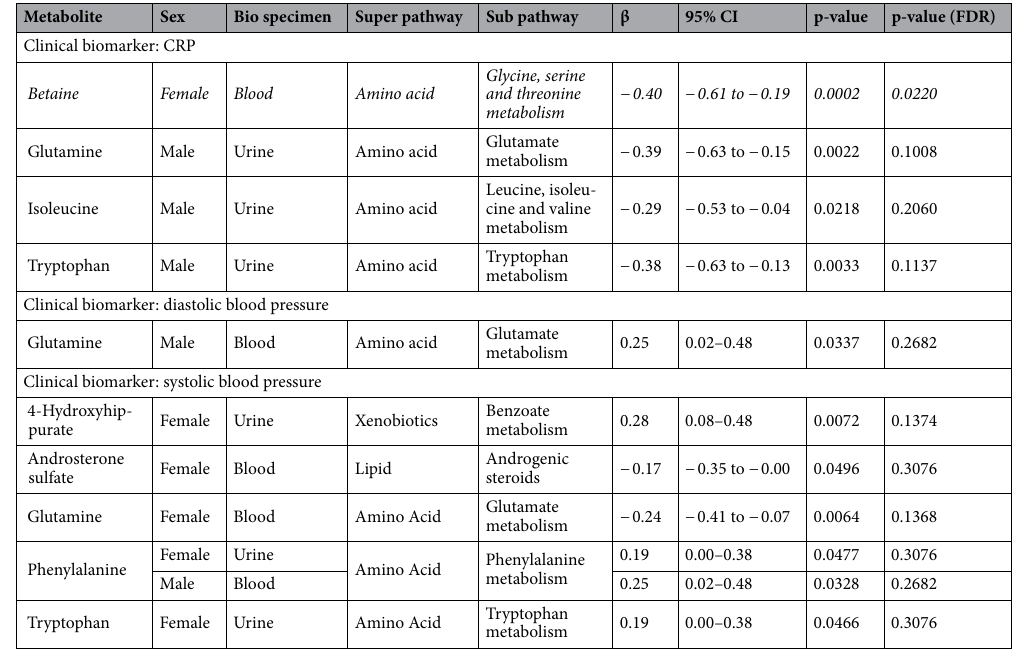
Table 3. Replicated risk-markers-metabolites association for CRP, diastolic blood pressure, and systolic blood pressure. Estimates are generated from linear regression. Models were adjusted for age and BMI, both at sample collection. Metabolites were log-transformed prior to analysis. Estimates and 95% CI are on the log scale. We controlled the false discovery rate (FDR) at 5% to account for multiple testing. Metabolites significant after correction for multiple testing are marked in italics.